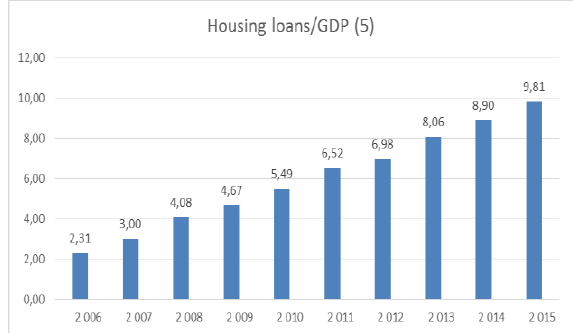
Figure 7. Housing Loans to GDP